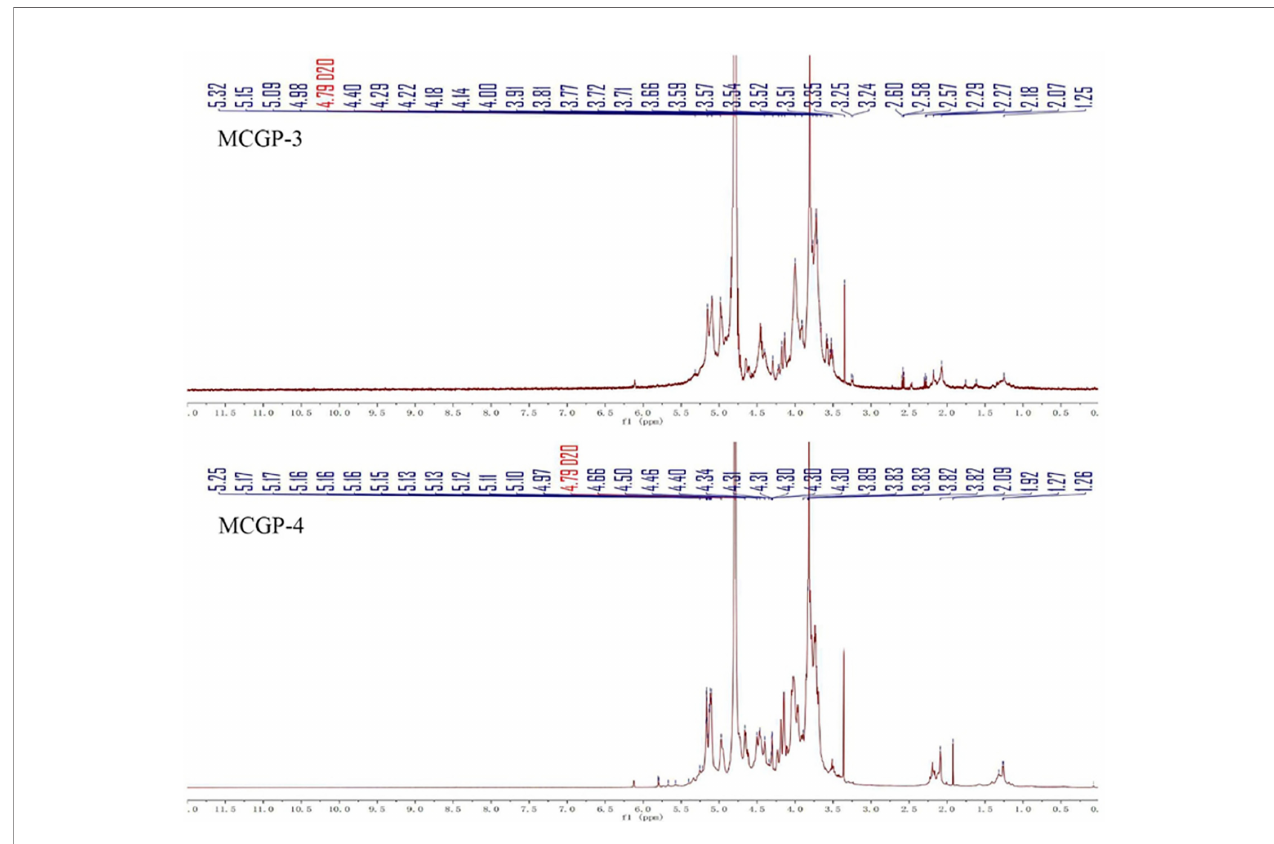
FIGURE 3 | 1 H NMR spectra of MCGP-3 and